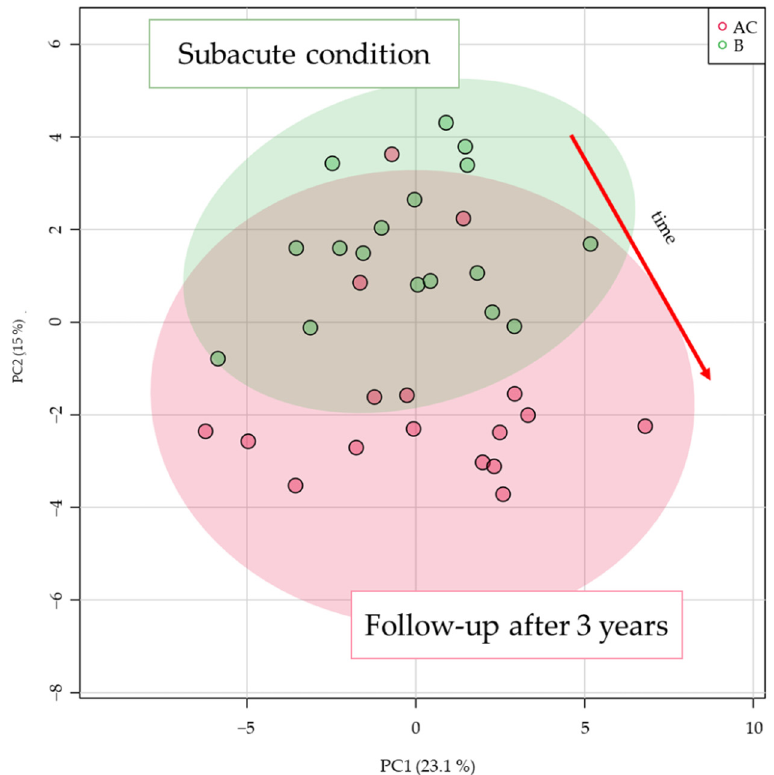
Figure 1. Principal component analysis (PCA) score plot based on all lipid species detected by liquid chromatography coupled to high-resolution accurate mass spectrometry (LC-HRMS)